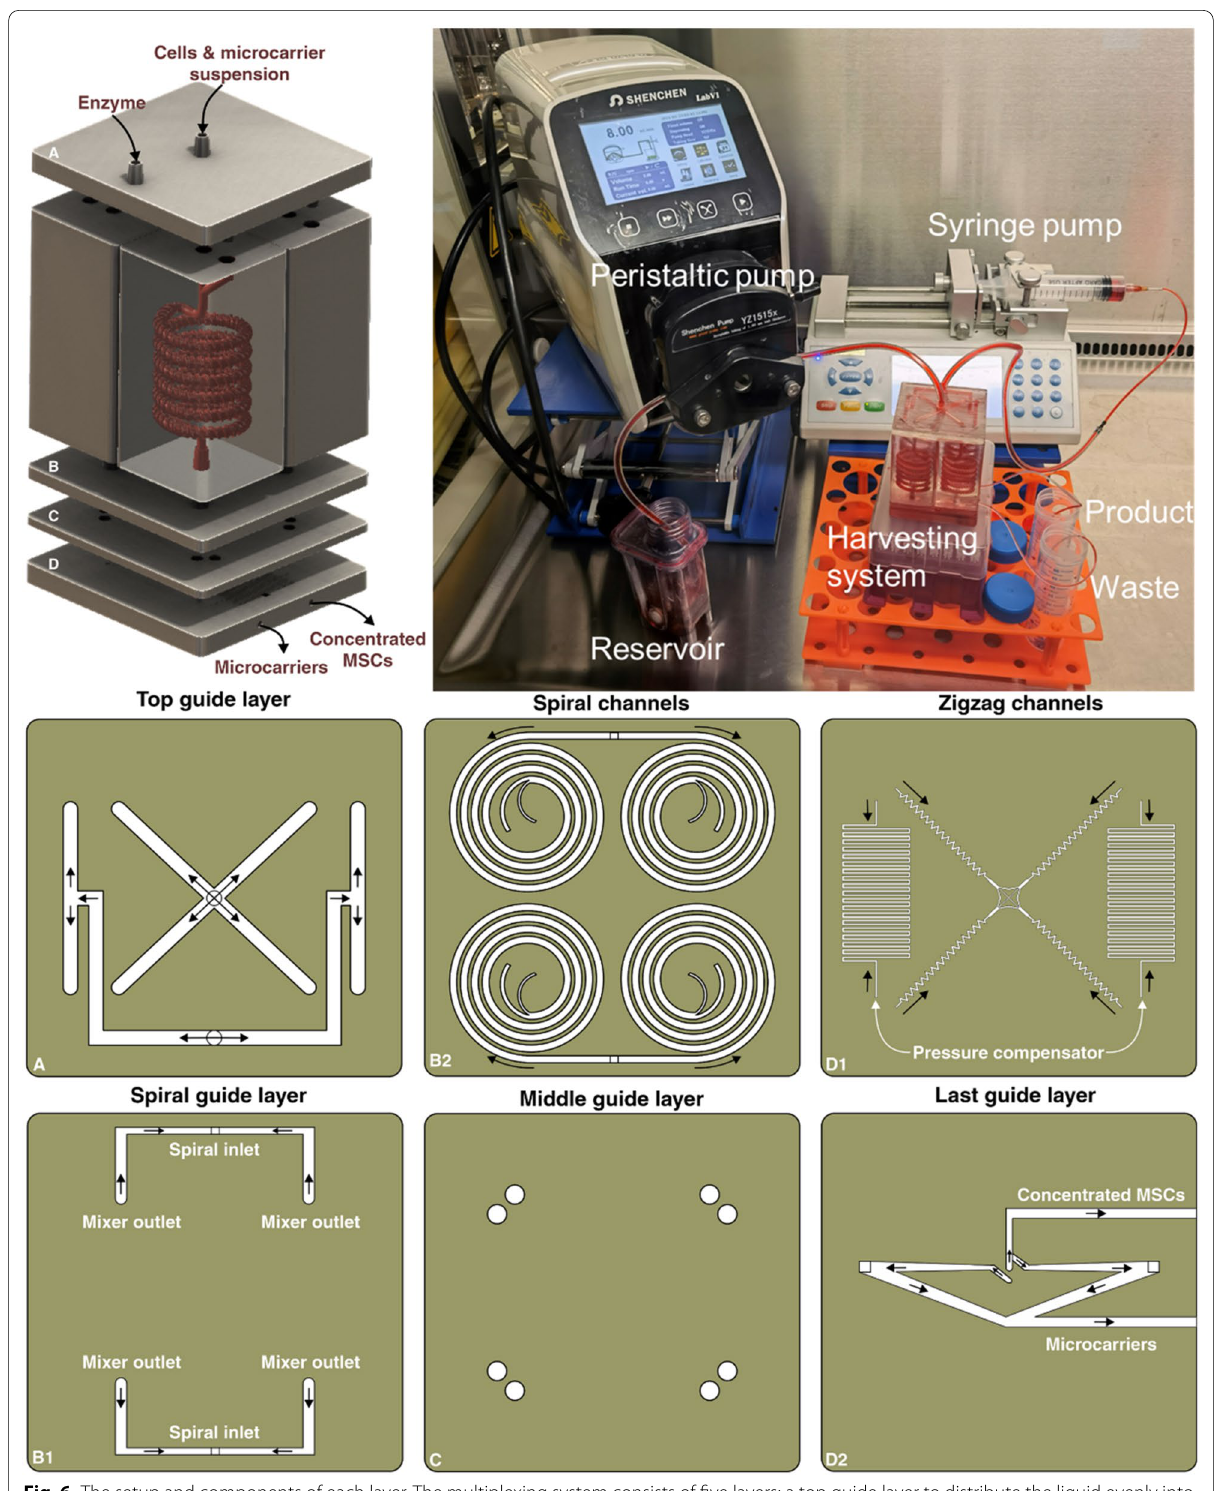
Fig. 6 The setup and components of each layer. The multiplexing system consists of five layers: a top guide layer to distribute the liquid evenly into the micromixers; a micromixers layer that detaches MSCs from MCs; a spiral layer separating MSCs and MCs; a middle guide layer that provided a base for spiral and zig-zag channels and a zig-zag channel and pressure-damping channel layer that concentrate the MSCs. The cells and MCs are left from the outlets,